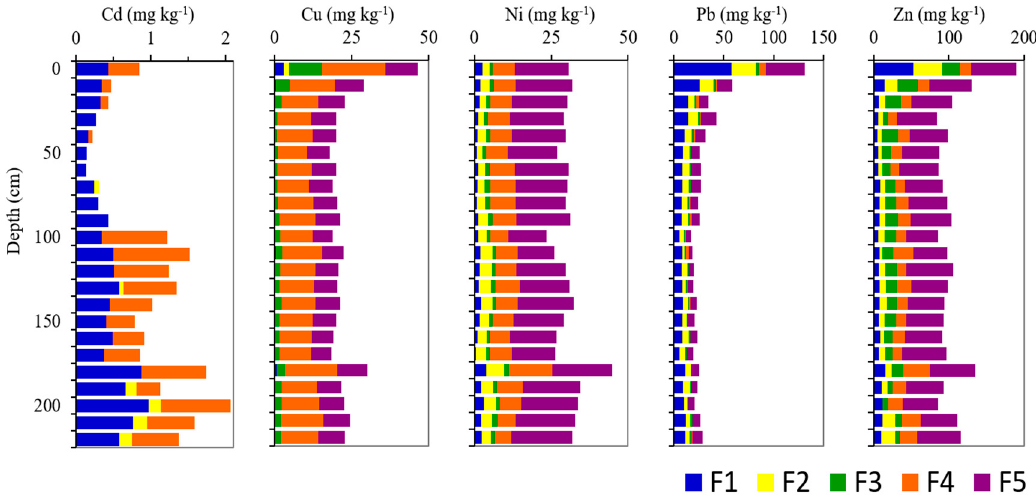
Figure 2. Vertical distribution of the metal fractions (Cd, Cu, Ni, Pb, and Zn) in the sediments of San Simon Bay. F1, metals present in exchangeable form and bound to carbonate; F2, metals present in the reductive phase bound to Mn-Fe oxides; F3, metals weakly bound to organic matter; F4, metals strongly bound to organic matter; F5, metals bound to sulfide. Table 1. Local background [Me] BG levels for trace elements (mg kg − 1 ).